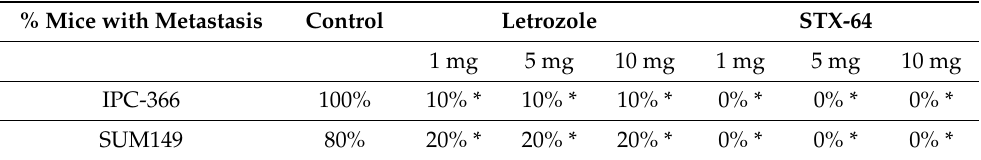
Table 2. Percentage of mice that developed metastasis in control and treated groups of IPC-366 and SUM149. * denoted significant differences between control and treatments.